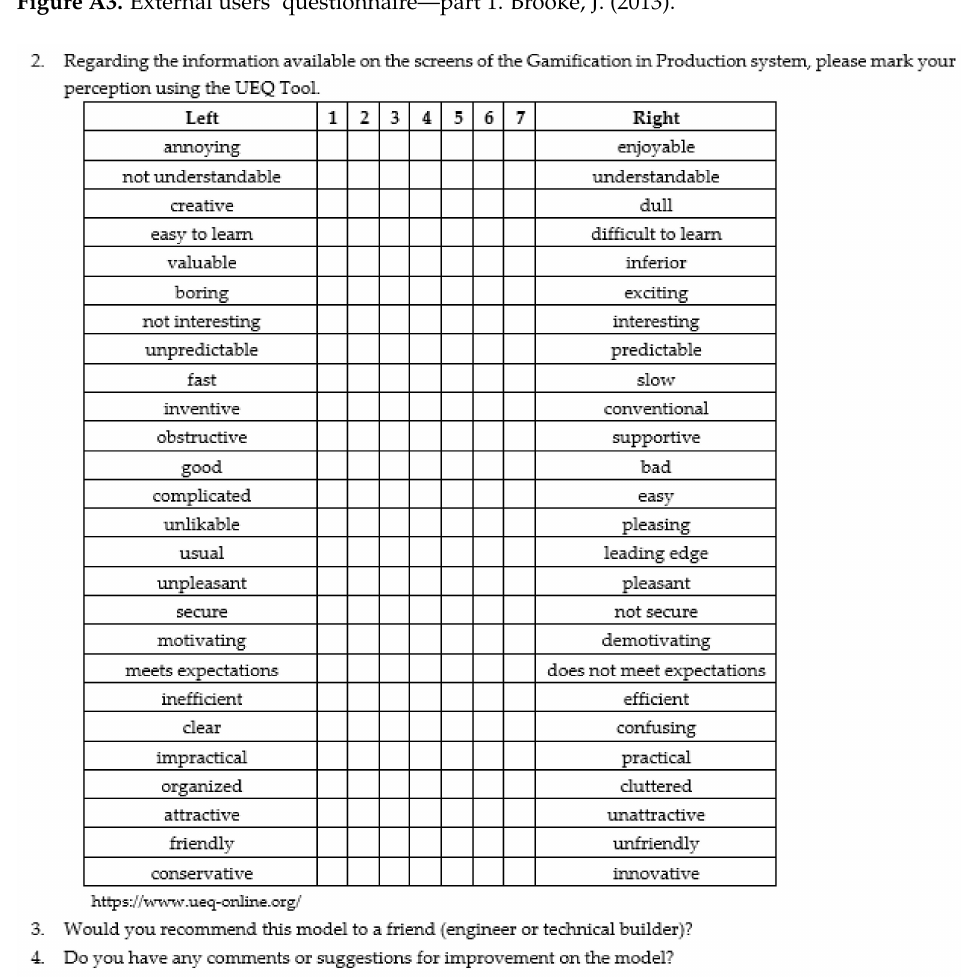
Figure A3. External users’ questionnaire—part 1. Brooke, J. (2013).